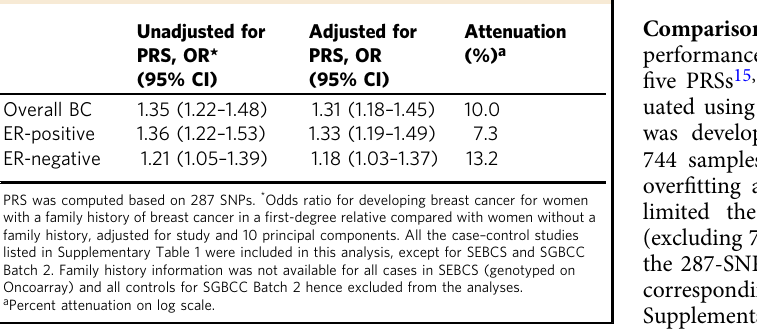
Table 3 First-degree family history of breast cancer and breast cancer risk in Asian